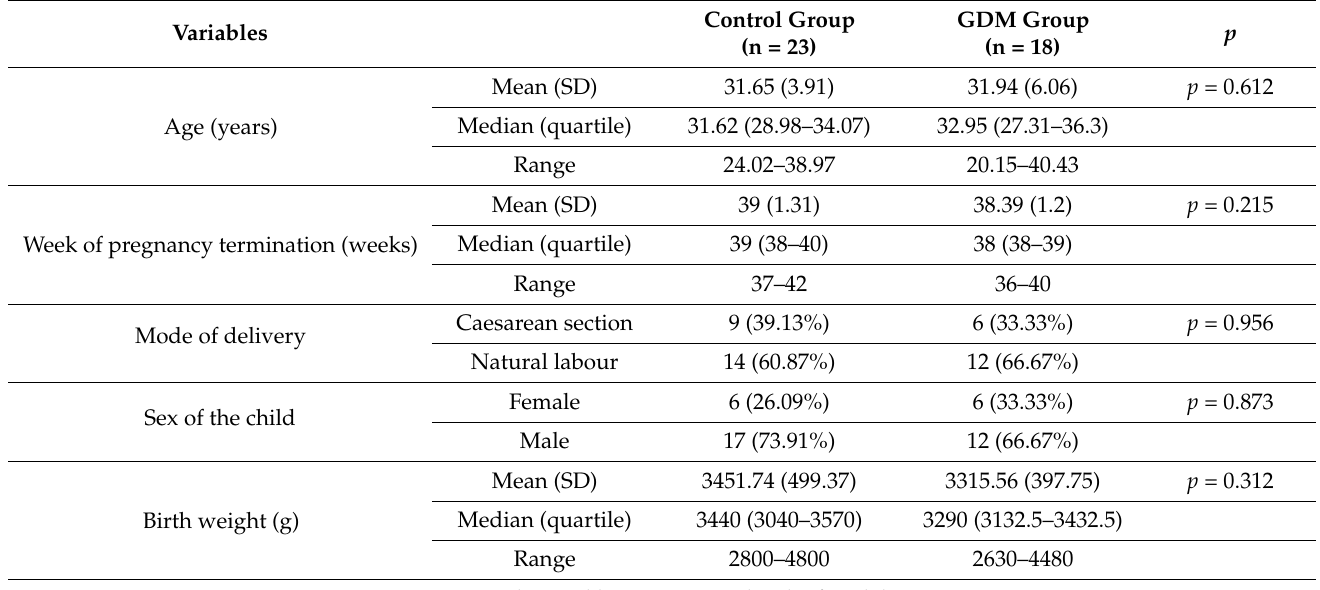
Table 2. Comparison of characteristics of the study